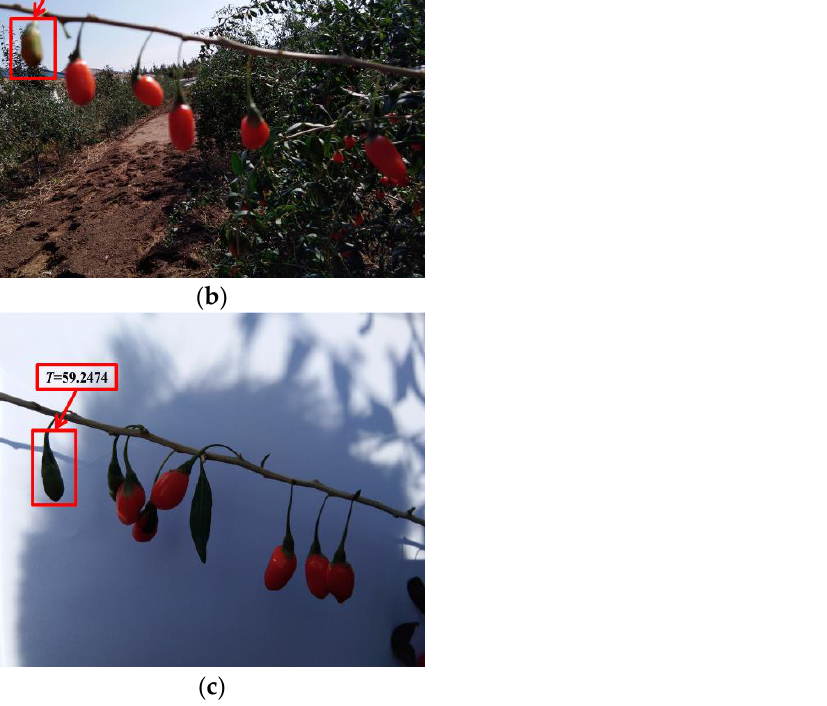
Figure 3. The eliminated abnormal samples of the ripe fruit ( a ), half-ripe fruit ( b ), and unripe fruit ( c ).